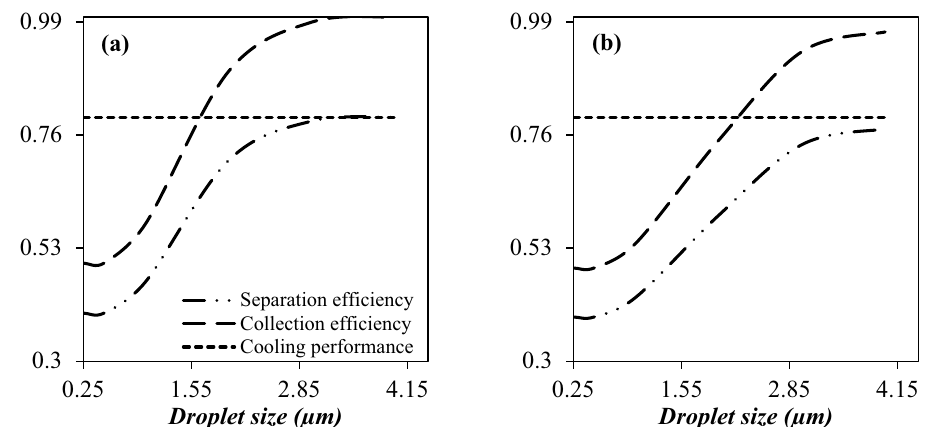
Figure 12. The influence of water ( a ) and condensate ( b ) droplet size on the separation efficiency.